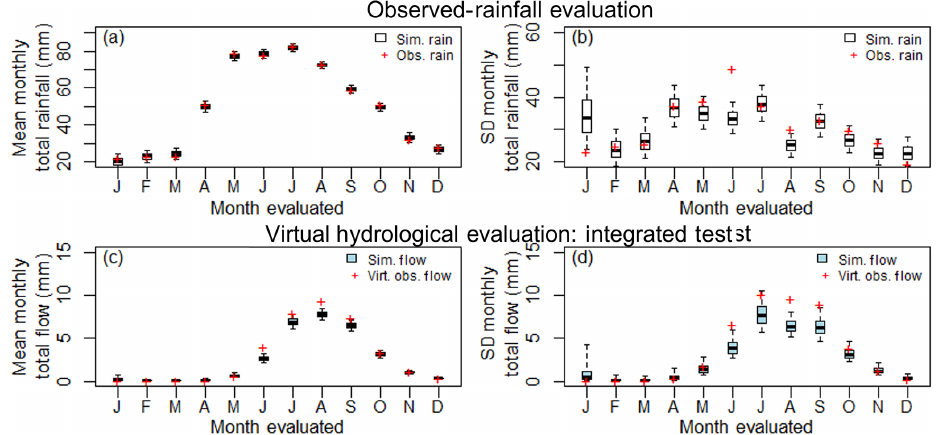
Figure 11. Happy Valley, Site 10 (a) observed-rainfall evaluation mean monthly total rainfall, (b) observed-rainfall evaluation standard deviation of monthly total rainfall, (c) virtual hydrological evaluation (integrated test) mean monthly total streamflow (d) virtual hydrological evaluation (integrated test) standard deviation of monthly total streamflow. Boxplot whiskers indicate the 90% limits of the simulated streamflow or rainfall